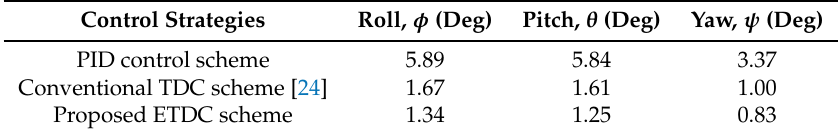
Table 3. RMS values of trajectory-tracking errors (Figure 5c) measured from 5 s to 10 s.